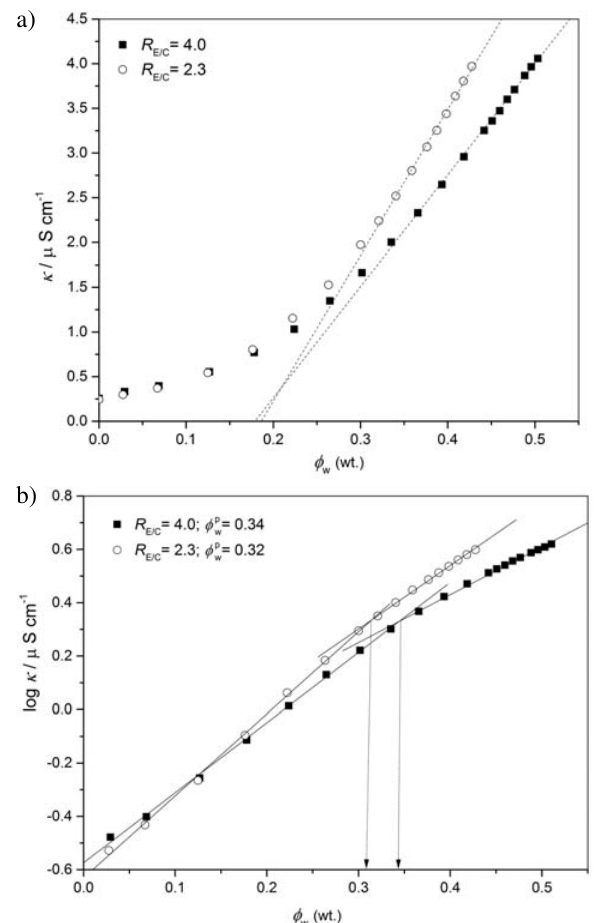
Figure 3 . 3a) Electric conductivity κ of the microemulsion as a at R = 4 and 2.3. 3b) The variation of log κ versus function of φ w E/C weight fraction of water along the dilution line R shown in Figure